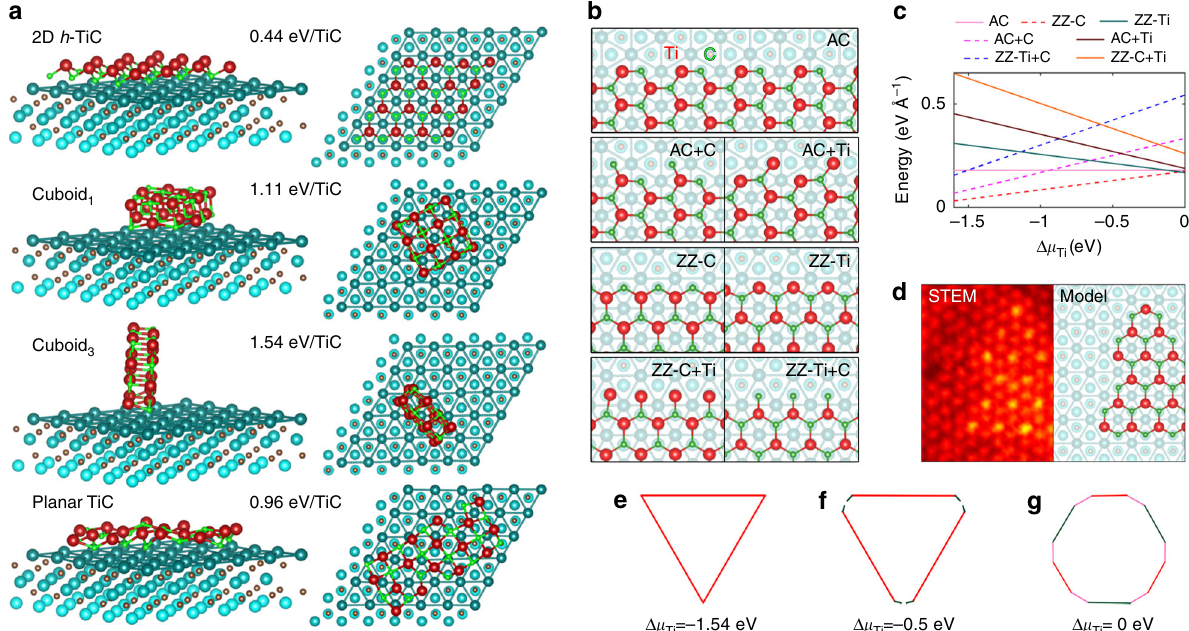
Fig. 4 Edges and equilibrium shapes of 2D h -TiC adlayer on Ti 3 C 2 surface. a Side view (left) and top view (right) of optimized crystal structure and formation energy of an h -TiC adlayer, two different cuboid shapes (cuboid 1 and cuboid 3 ), and planar TiC, all composed of 16 atoms, on Ti 3 C 2 surface. b Structural models of the edge structure of h -TiC adlayer on Ti 3 C 2 , including standard armchair (AC), Ti- and C-oriented zigzag (ZZ-Ti and ZZ-C) edges, and cases when they are terminated with Ti or C atoms. The Ti and C atoms in the h -TiC adlayer are red and green respectively. c Calculated edge energies of h -TiC on Ti 3 C 2 as a function of Ti chemical potential difference, Δ μ Ti . d An experimental STEM image and simulated model showing the triangular island and the ZZ-C edge crystal structure model. e – g The equilibrium shape of h -TiC on Ti 3 C 2 at varying Δ μ Ti : − 1.54 eV ( e ), − 0.50 eV ( f ), and 0 eV ( g ). The colored outlines represent different types of edge